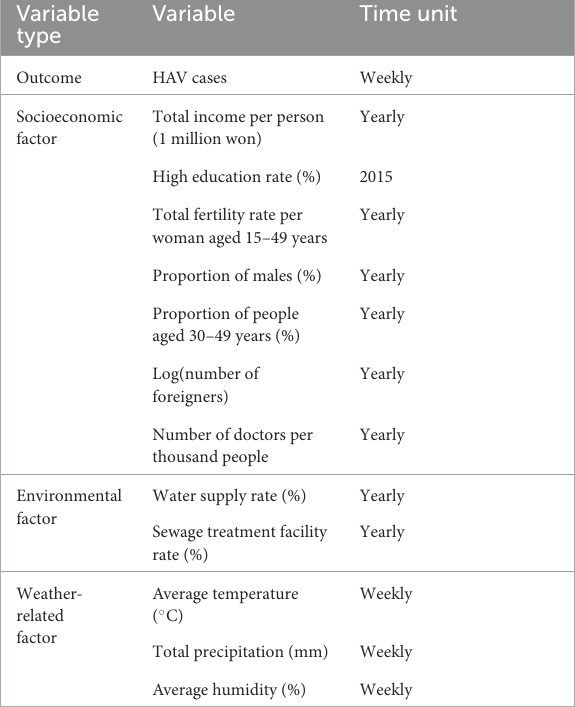
TABLE 1 Description of data set (outcome, socioeconomic factors, environmental factors, and weather-related